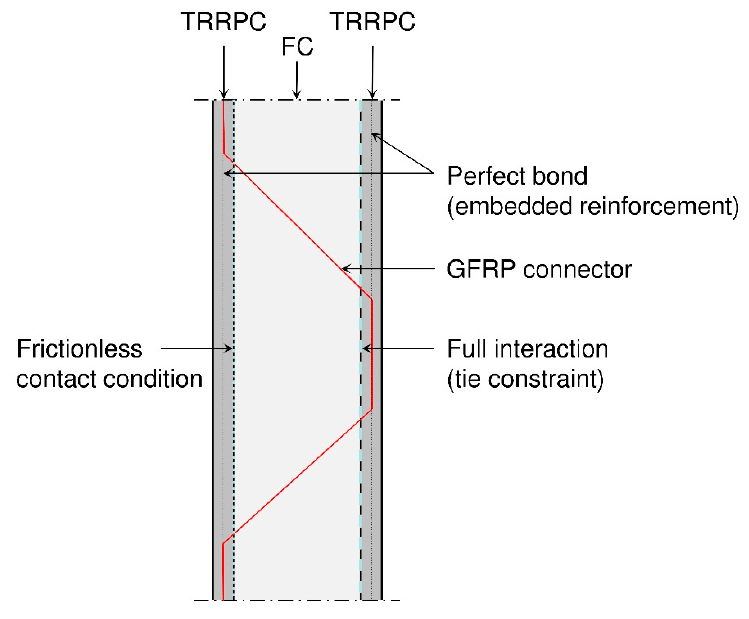
Figure 9. Schematic of the prescribed interaction conditions for the FE-model.